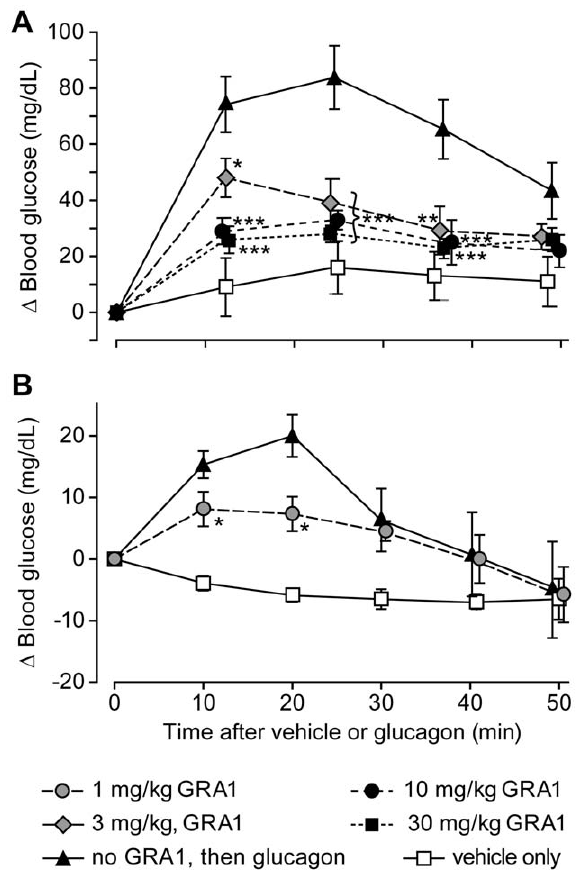
Figure 3. Blunting of glucagon-induced blood glucose excur- sions by GRA1 treatment in the (A) hGCGR mouse and (B) rhesus monkey. In (A), mice (n=8) were administered vehicle or 3, 10 or 30 mg/kg GRA1, then challenged 1 h later (time 0) by intraperitoneal injection of 15 m g/kg glucagon or vehicle. Pharmacokinetic analysis determined that these animals had mean plasma GRA1 concentrations of 0.4, 0.9, and 4.7 m M, respectively, at 1 h postdose. In (B), monkeys (n=4) were administered 1 mg/kg GRA1 4 h prior to intramuscular injection of 15 m g/kg glucagon or vehicle. At 1 h postdose, the mean plasma GRA1 concentration in these animals was 0.2 m M. *p , 0.05; **p , 0.01; and ***p , 0.001 vs. glucagon-treated control animals.